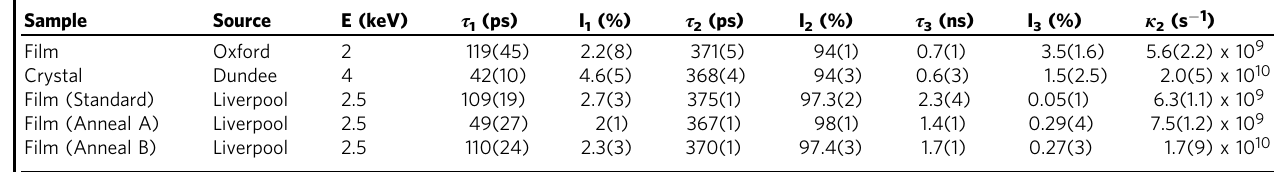
Table 2 Experimental positron lifetime component results for MAPbI 3 thin fi lm and single crystal samples.